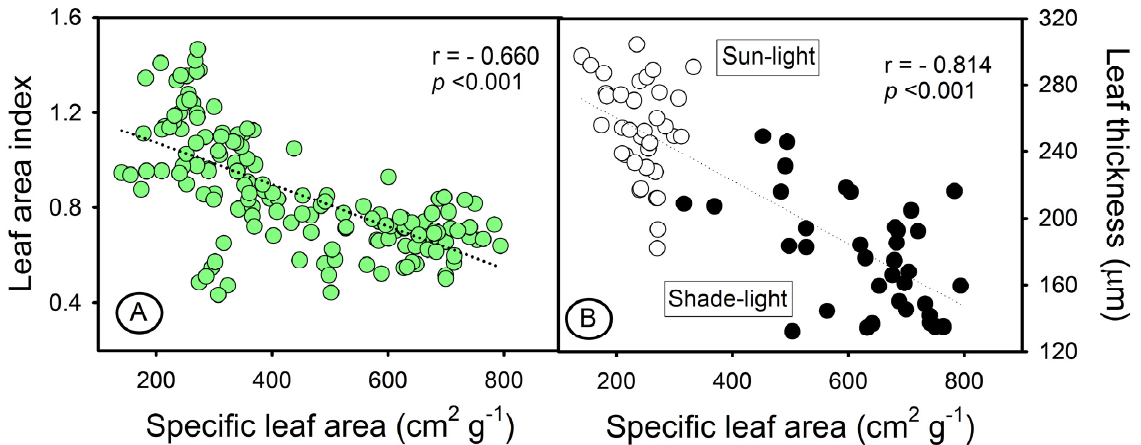
Figure 5. Correlations between intrinsic parameters and the influence of leaf optical properties. ( A ) Specific leaf area (SLA) and leaf area index (LAI). ( B ) Specific leaf area and leaf thickness in sunlight and shade light. Green dots show total plants; white sunlight plants; black shade-light plants. The structural components and optical properties of tobacco leaves can be influenced by environmental factors and plant hormones, including but not limited to light intensity, growth inhibitors, GA 3 , cytokinins, and ascorbic acid. These factors can result in changes in leaf thickness (Figure 6A–C), the number of parenchyma layers, and chloroplast ultrastructure [8,10]. The arrangement and amount of chloroplasts and thylakoids have a significant impact on the green/yellow region (500–600 nm) of the leaf’s optical properties [10,39]. However, the blue (440–485 nm) and red (626–700 nm) regions of the spectrum are less impacted and not statistically significant ( p > 0.05) [8,10]. These findings, confirmed by transmission microscopy (Figure 6D–F), emphasize the importance of considering the role of sensors in measuring the optical properties of leaves to accurately represent leaf behavior in vivo .